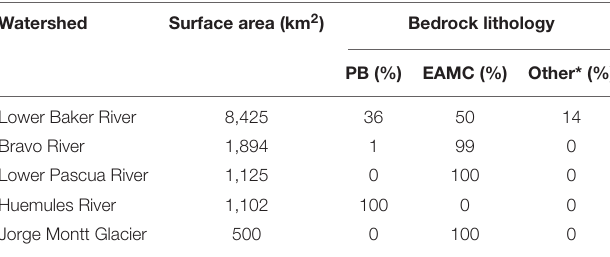
TABLE 1 | Surface area of the four studied river watersheds and Jorge Montt Glacier, and areal proportions of the corresponding bedrock lithologies (Gómez et al.,